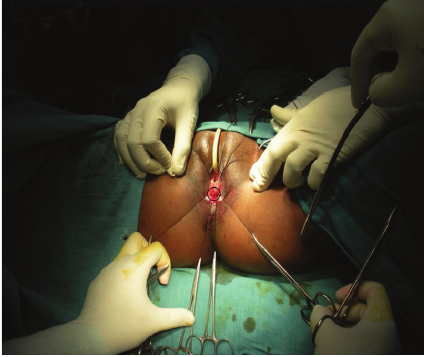
Figure 1: Showing anovestibular fistula in an adult female patient with openings of urethra and vagina. Note no separate anal opening.